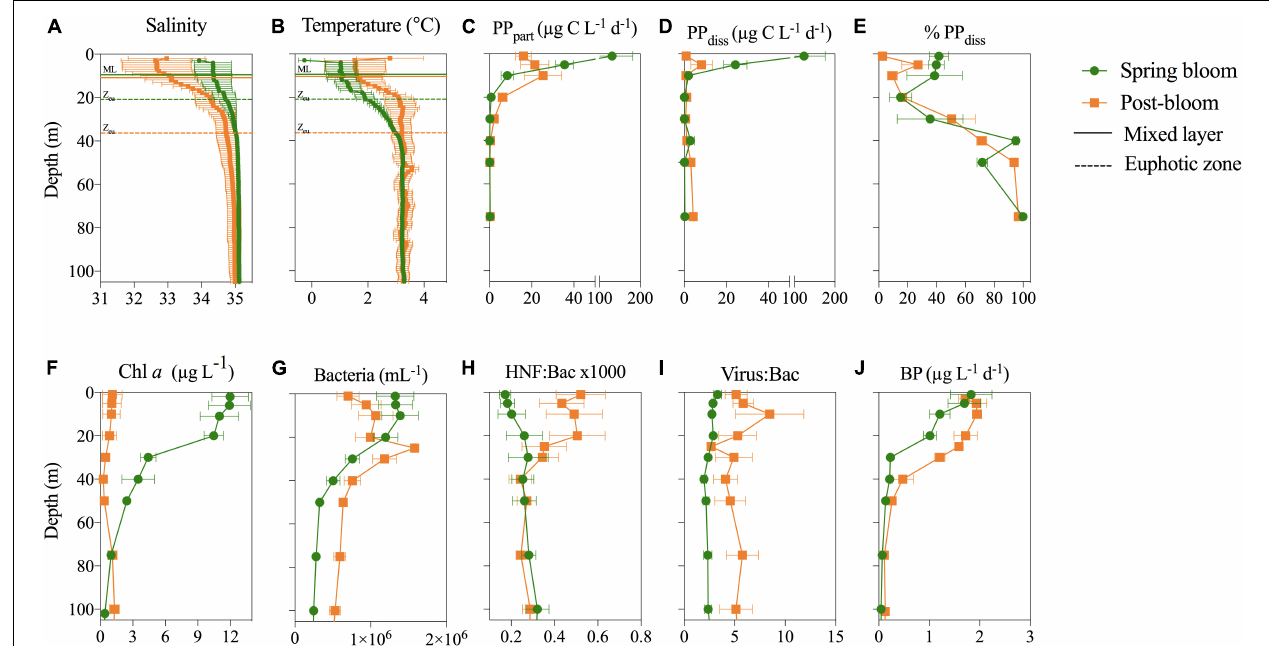
FIGURE 4 | Depth profiles of (A,B) salinity and temperature and horizontal lines marking the mixed layer depth (ML) and the euphotic zone (Z eu ). (C–E) Particulate and dissolved primary production (PP part and PP diss , respectively), as well the per cent of PP diss out of total PP. (F–J) Chl a concentration ( µ g L − 1 ), bacterial abundance (mL − 1 ), the ratio of heterotrophic nanoflagellates (HNF:Bac 1000 × ) and viruses (Virus:Bac) to bacteria, and bacterial production (BP, µ g L − 1 d − 1 ). All data is shown as an average ± SE of the three stations sampled during the spring bloom in May (P1–P4) and post-bloom in August (P5–P7),